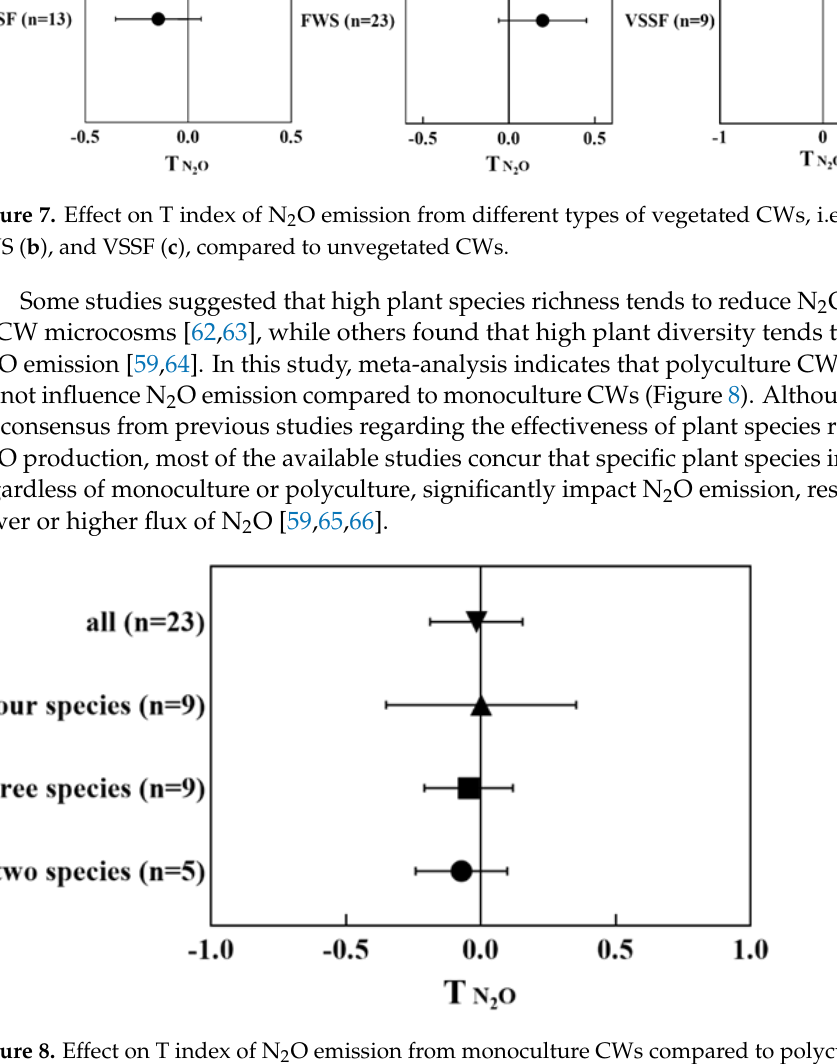
Figure 7. Effect on T index of N 2 O emission from different types of vegetated CWs, i.e., HSSF ( a ), FWS ( b ), and VSSF ( c ), compared to unvegetated CWs.